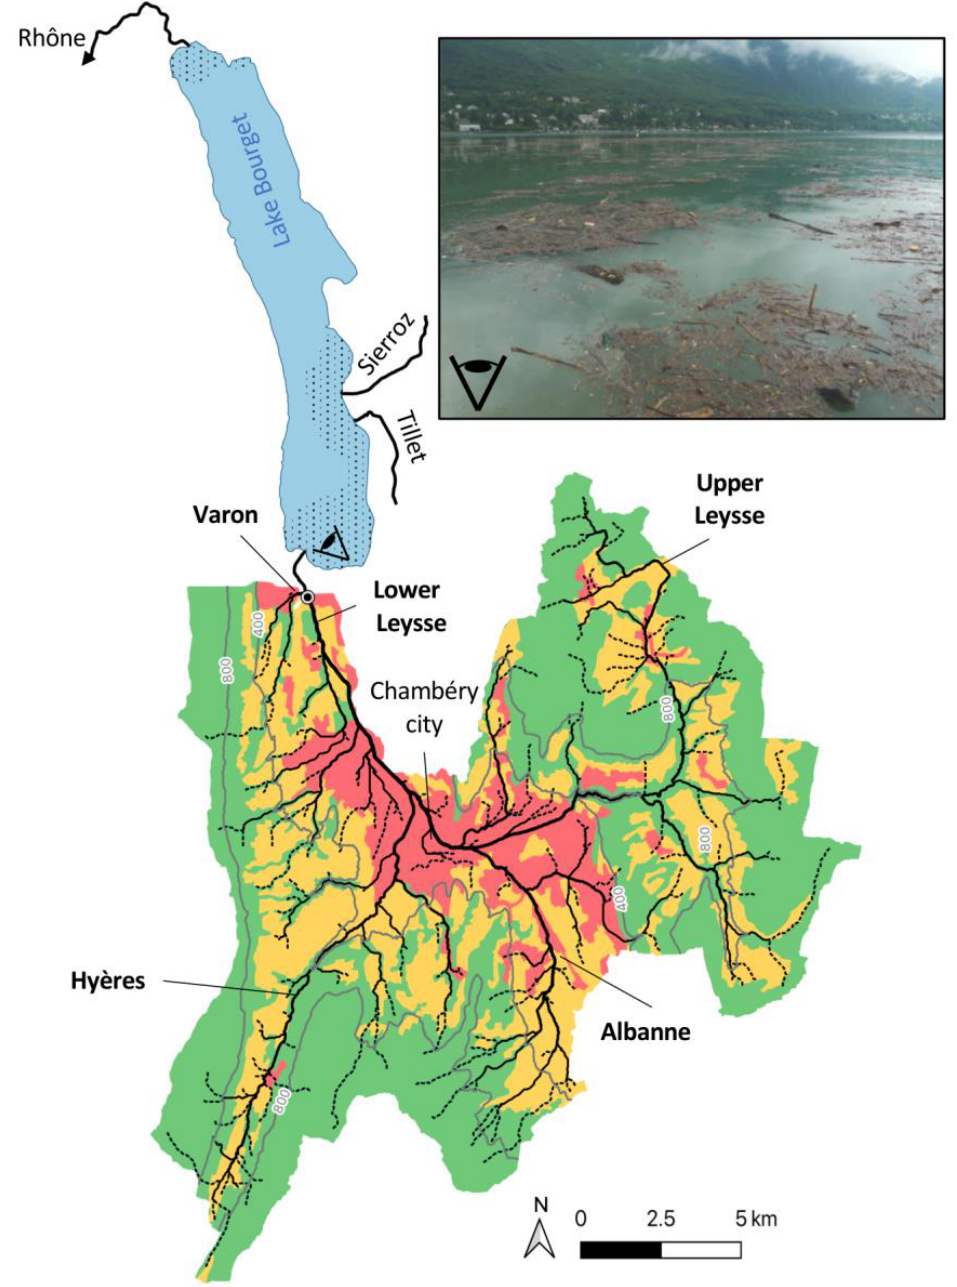
Figure 1. Map of the Leysse River catchment. Land uses are shown following Corine Land Cover (green: forest; yellow: agriculture; red: urban). The elevation contour lines 400 m and 800 m are shown in gray. Rivers are indicated in black, intermittent creeks being in dotted lines. The black dot indicates the university bridge where CPOM measurements were made. The dotted area in Lake Bourget indicates the presence of gas bubbles in the sediment [32]. The photograph showing floating litter on the lake was taken after a large flood.